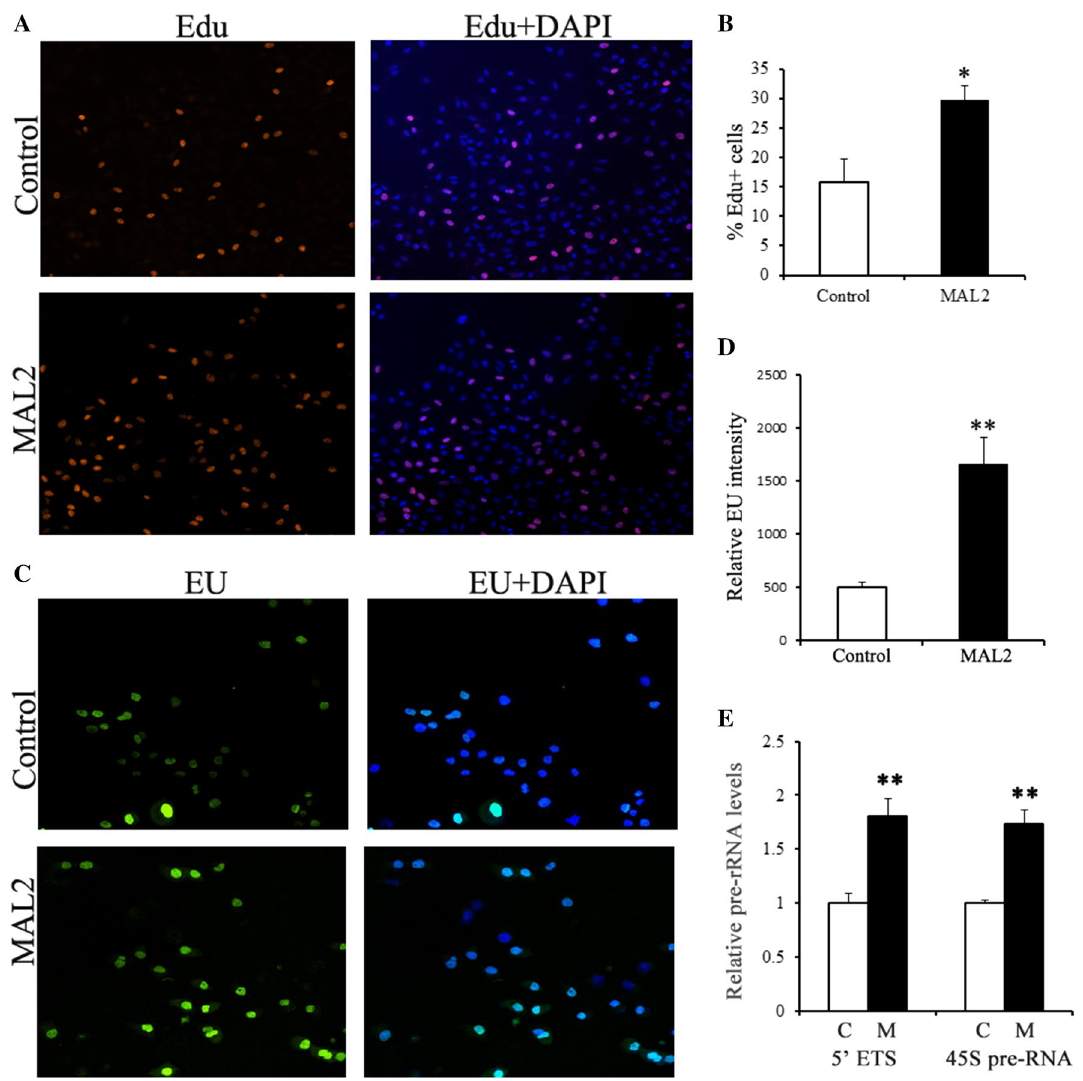
Fig. 4 Enhanced rRNA synthesis and cell proliferation in A549 cells with MAL2 over-expression. A , C DNA synthesis (EdU, red) and rRNA syn- thesis (EU, green) in control cells and MAL2 over-expression cells. Three independent experiments were performed and six replicate wells for each experiment. B , D Quantifications of EdU and EU in A , C , *p < 0.05, **p < 0.01. E qRT-PCR of 5 ′ ETS and 45S (pre)-rRNA transcript in con- trol cells and MAL2 over-expression cells. Data in E are mean ± SEM of three replicates; t-test, **p <